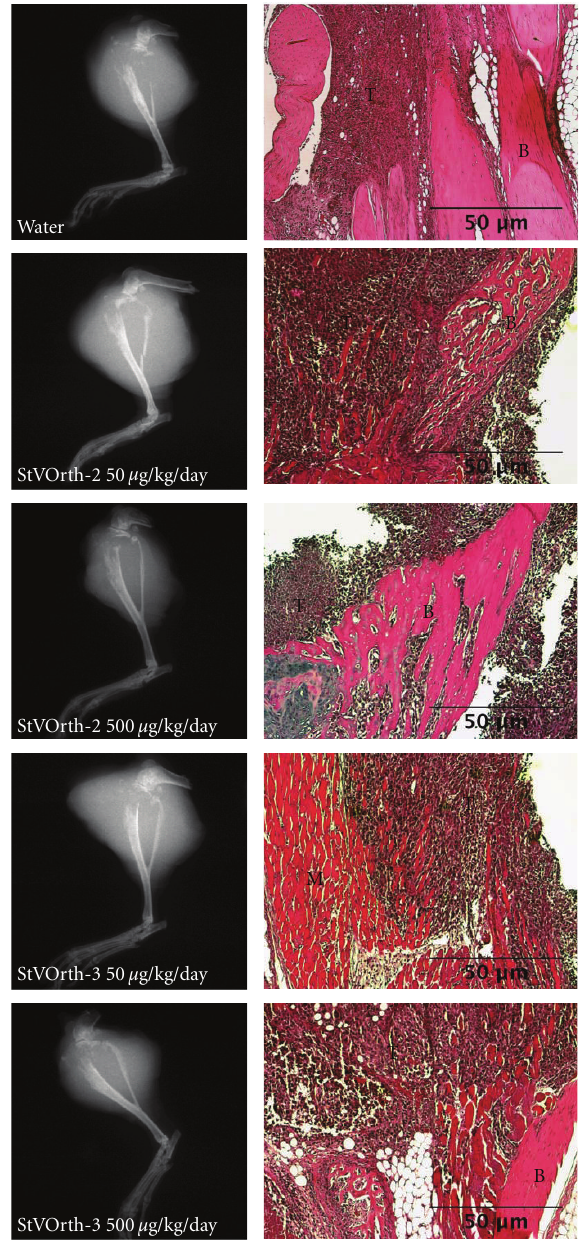
Figure 4: Tumour invasion. Plain radiographs (left) of tumour- bearing limbs show extensive osteolysis of proximal tibiae and soft tissue extension for all treatment groups. Haematoxylin and eosin- stained sections of orthotopic tumour (right) show tumour cells (T) invading bone (B) and skeletal muscle